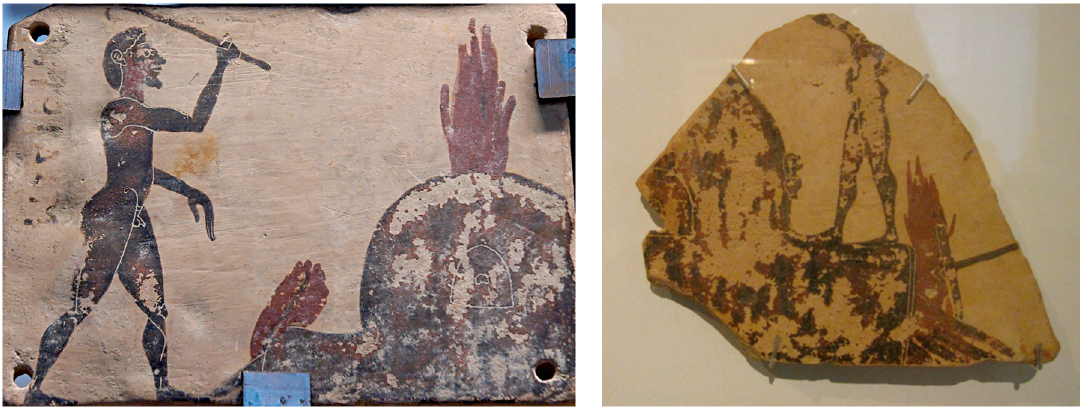
Figure 14. The beginning of reduction. Penteskouphia pinakes, Corinth, 575–550 BCE, Left: MNB 2858, Louvre, Image from: https://commons.wikimedia.org/wiki/File:Plaque_Penteskouphia_MNB2858.jpg; Right: F827, Berlin Antikensammlung. Author’s own image.